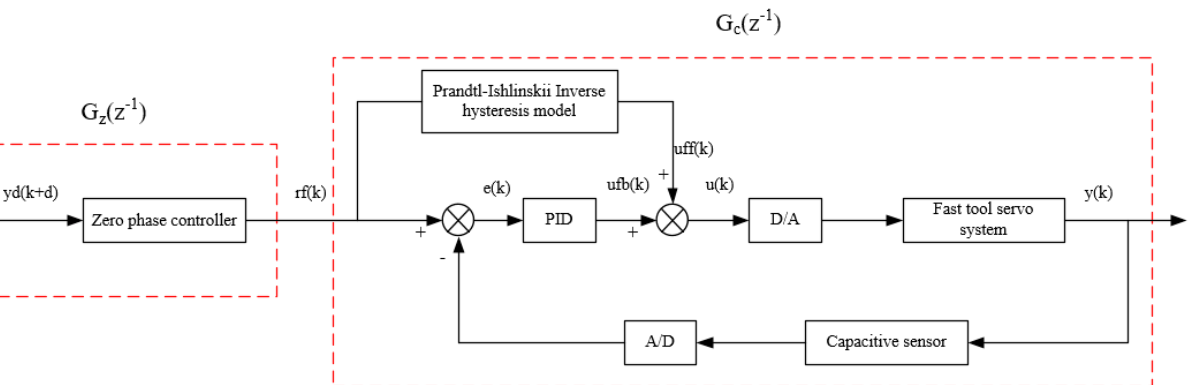
Figure 4. ( a ) Model of the flexure hinge tool holder; ( b ) first-order vibration mode.